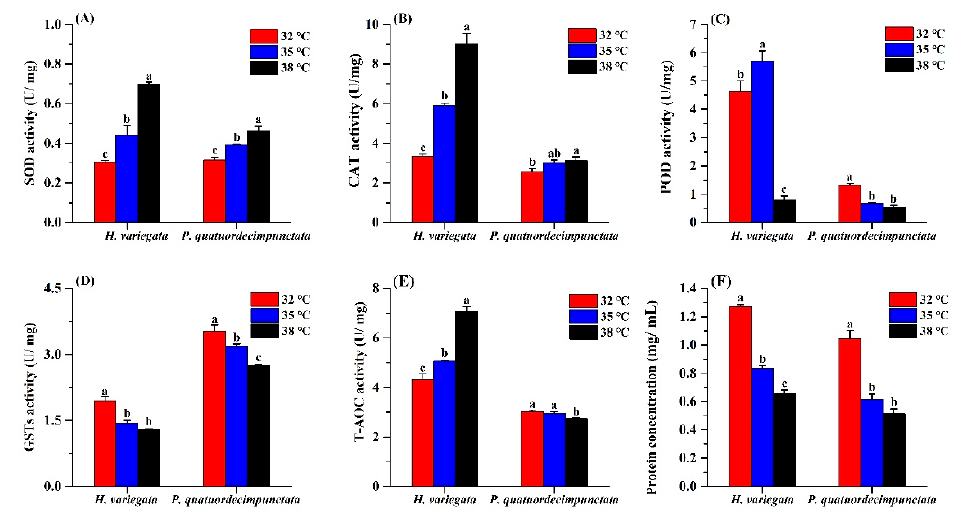
Figure 4. Effects of temperature stress on the antioxidant capacity of Hippodamia variegata and Propylaea quatuordecimpunctata : ( A ) SOD activity; ( B ) CAT activity; ( C ) POD activity; ( D ) GSTs activity; ( E ) T-AOC activity; ( F ) protein concentration. Different letters above the bars indicate statistically significant difference at p < 0.05 (ANOVA followed by a Tukey’s post hoc test).